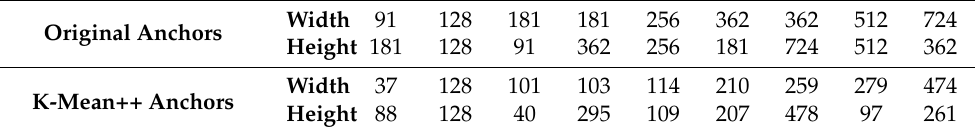
Figure 8. The distribution of width and height of annotated bounding boxes in the cargo ship dataset. The red dots represent the clustering results. Table 3. Comparison between original anchors and K-Mean++